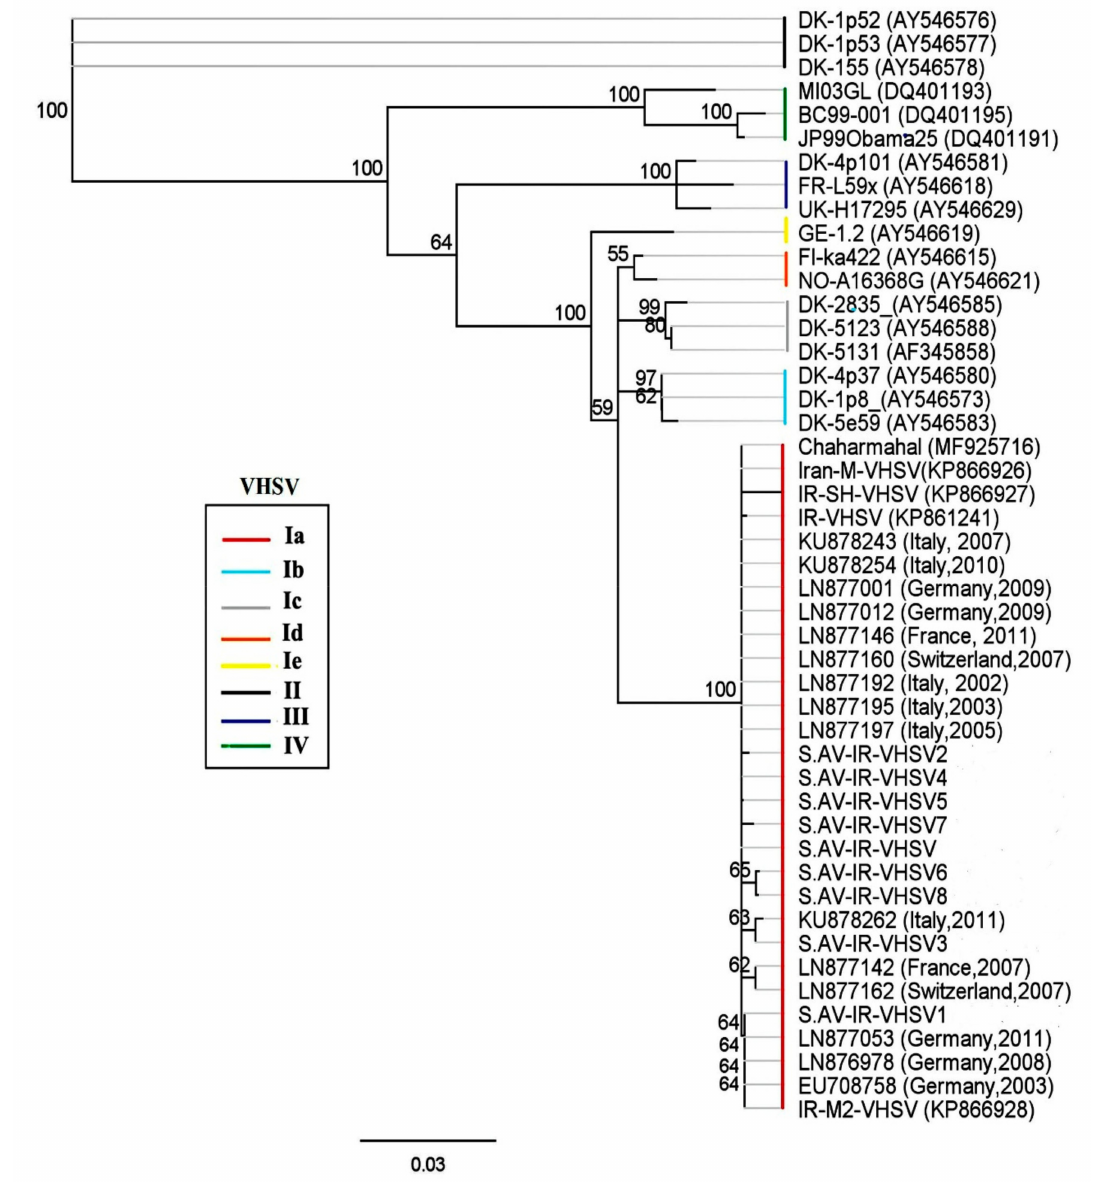
Figure 2. Phylogenetic analysis of Iranian isolate of VHSV based on the partial nucleotide sequences of G gene (513 bp). The phylogenetic trees were constructed using the Geneious Prime (Neighbor-joining with the Hasegawa-Kishino-Yano (HKY) model and 1000 bootstrap replicates). The Iranian isolates of VHSV (S.AV-IR-VHSV to S.AV-IR-VHSV8) were classified as an Ia genogroup (European origin). GenBank accession numbers are listed in Table